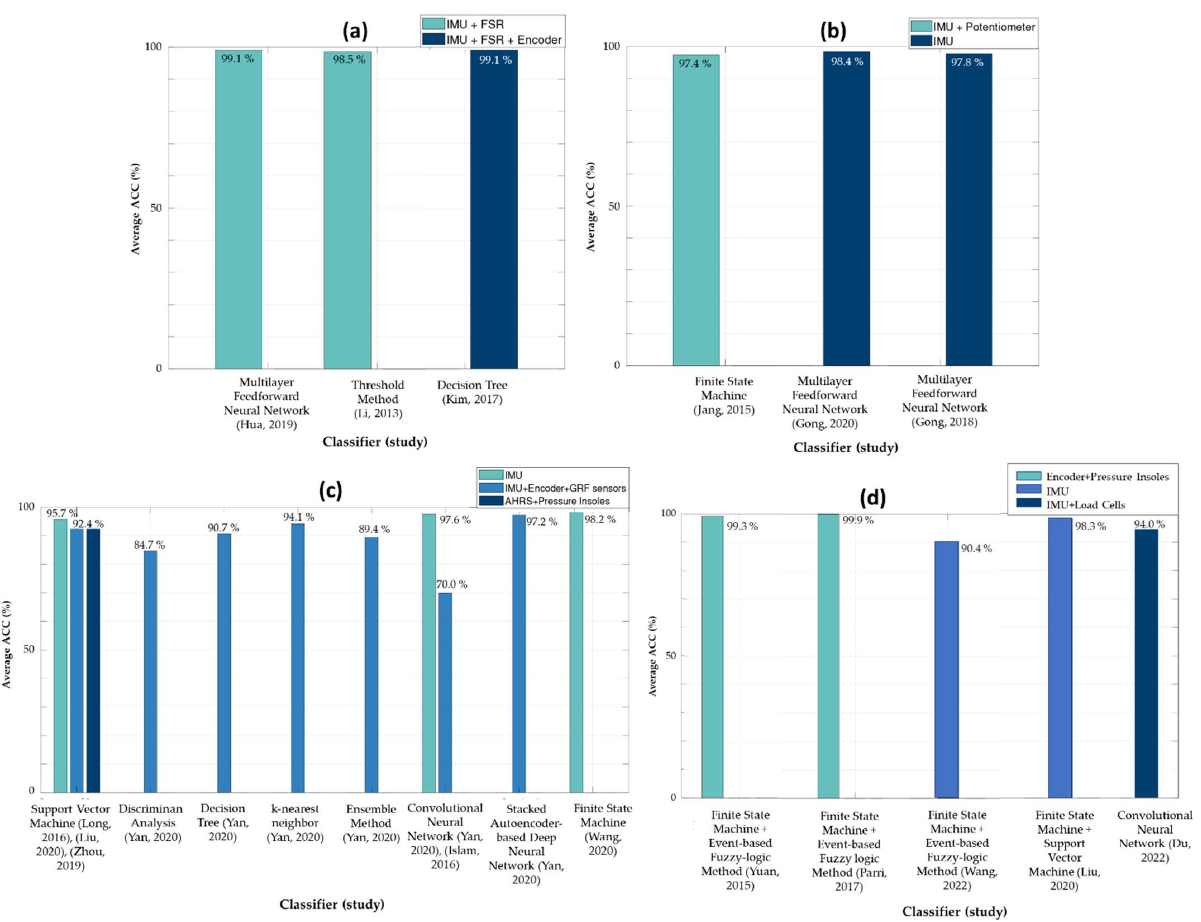
Figure 3. Average accuracies reported by: ( a ) studies [4,13,31] able to decode continuous dynamic LMs; ( b ) studies [3,11,12] able to decode continuous dynamic and static LMs; ( c ) studies [5,8–10,29,31] able to decode continuous and discrete dynamic LMs; and ( d ) studies [6,7,9,34,35] able to decode static, continuous, and discrete LMs. The standard deviation was not presented for reasons of simplicity.